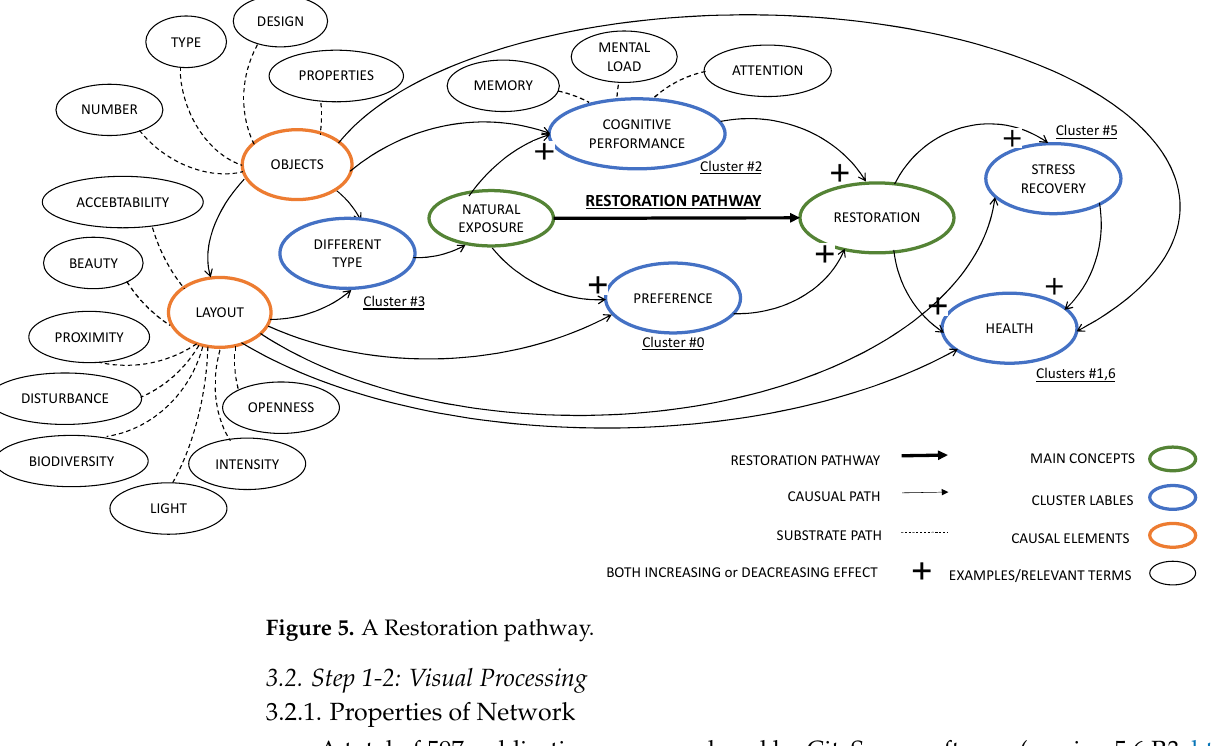
Figure 5. A Restoration pathway.